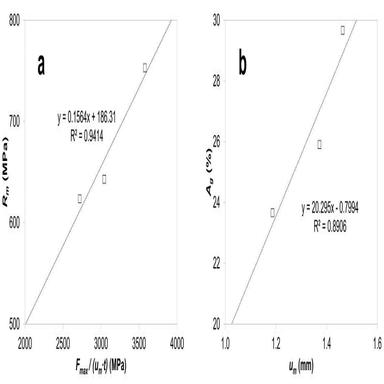
SP to uniaxial correlations for LPBF DSS 2205 (a) Rm vs. Fmax/um•t (b) Ag vs. um.